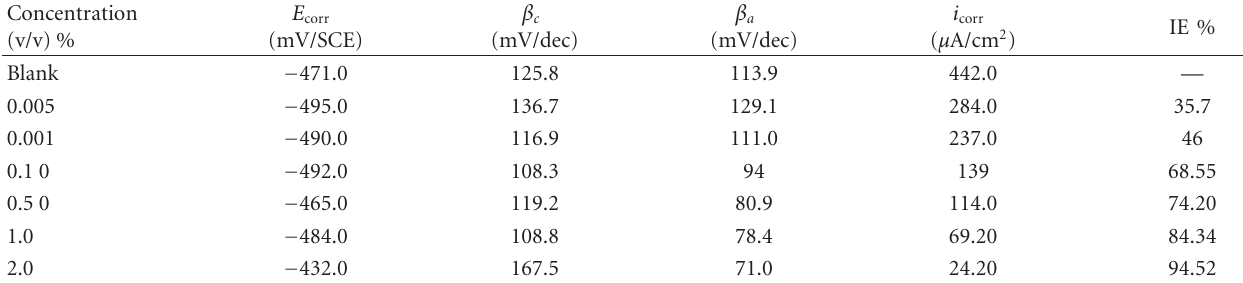
Table 3: Polarization parameters for carbon steel in 1M HCl at room temperature containing various concentrations of Pachycormus dis- color ethanol extract.